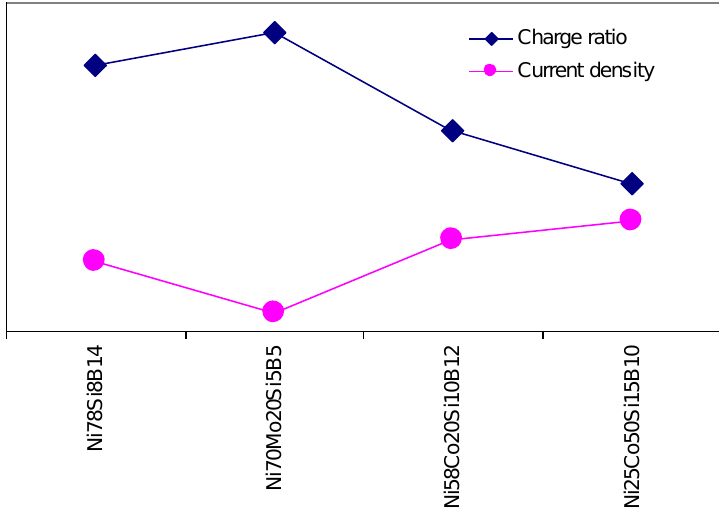
Figure 11. A comparison between the charge ratio at positively charged sites and the current density, at an overpotential of 0.6 V, within the Ni alloys investigated in this study. The scales are different for the two curves, and are here left out for